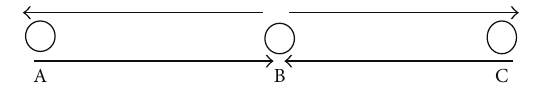
Figure 1: Trajectory of